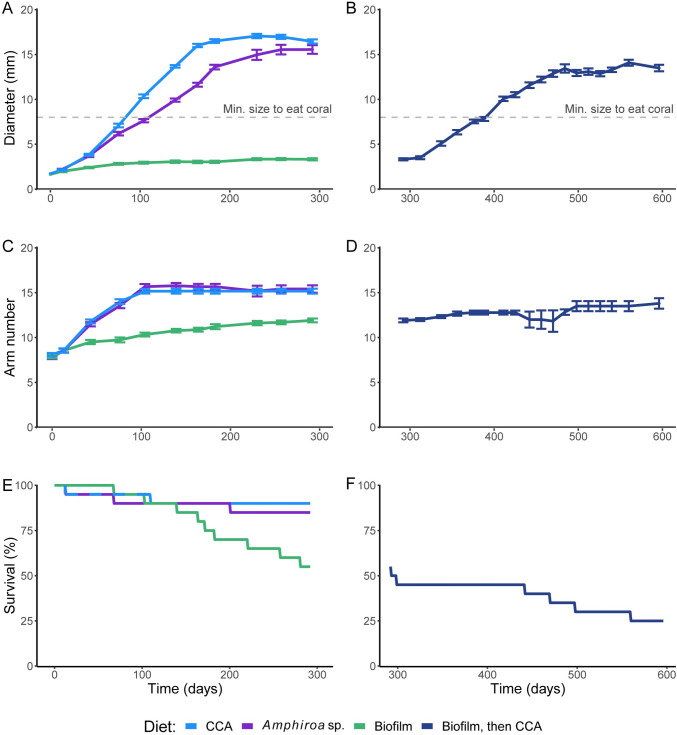
The growth and survival of herbivorous juvenile crown-of-thorns sea stars on three different diets.(A,B) The diameter (mean ± SE), (C-D) number of arms (mean ± SE), and (E-F) survival (%) of juveniles fed crustose coralline algae (CCA), Amphiroa sp., or biofilm for 292 d (left panels) and juveniles that were raised on biofilm and then fed CCA for an additional 304 d (right panels). The horizontal dashed lines (A-B) represent the approximate minimum size that juveniles can transition to a coral diet [7]. Juveniles were ≤3 months old at the start of the experiment (To).